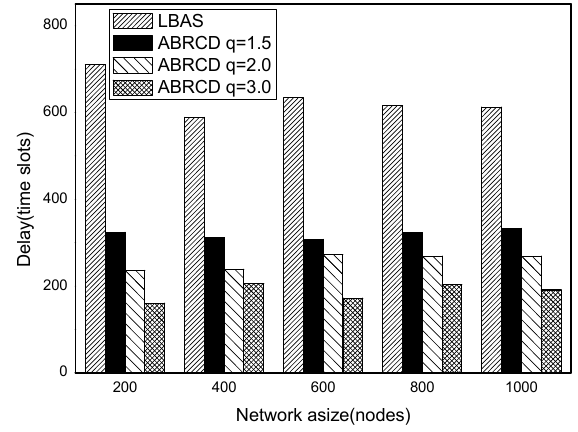
Figure 45. The impact of network size with fixed | T | = 60 on delay.